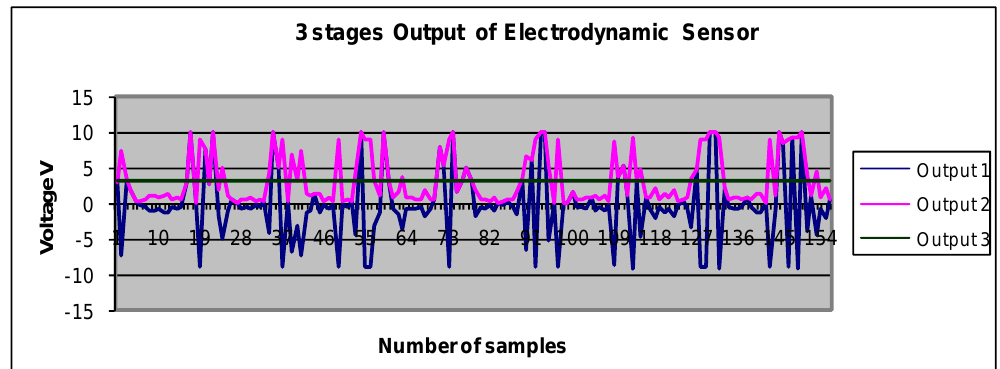
Figure 9. Sensor voltage outputs 1, 2 and